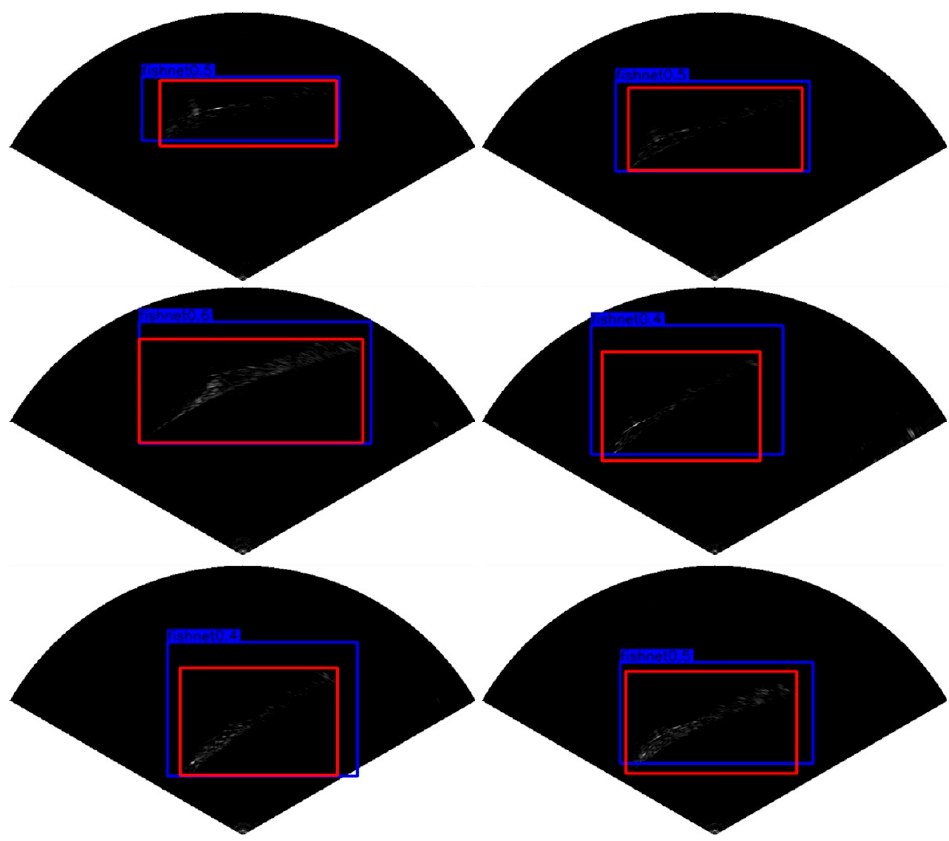
Figure 17. The real-time results of detecting fishing nets with our proposed MRF-Net. Note: the